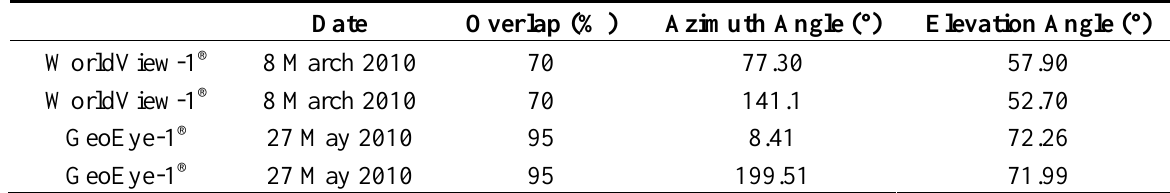
Table 1 Characteristics of the stereoscopic satellite images that were acquired by the GeoEye-1 ® and WorldView-1 ®